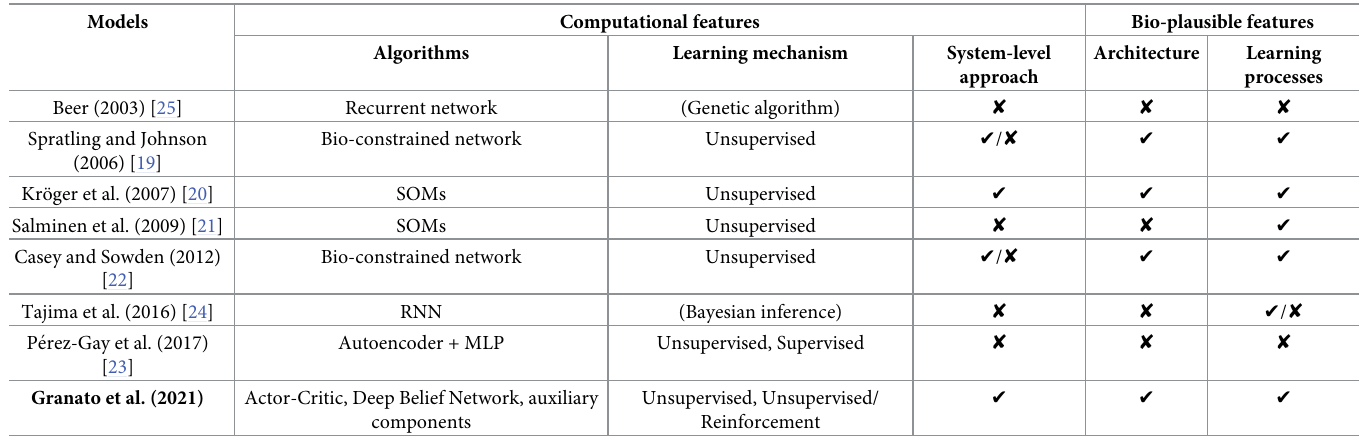
Table 3. Overview of the main features of the computational models on categorical perception considered here.